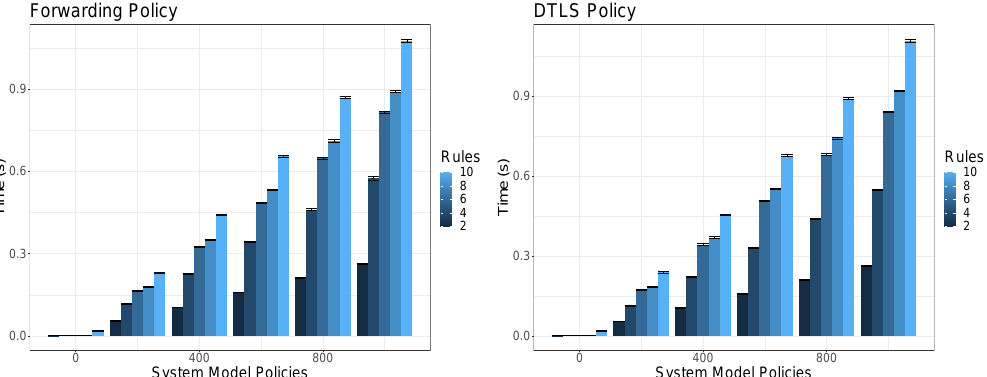
Figure 7. Conflict detection performance of network forwarding and DTLS policies according to the rules.